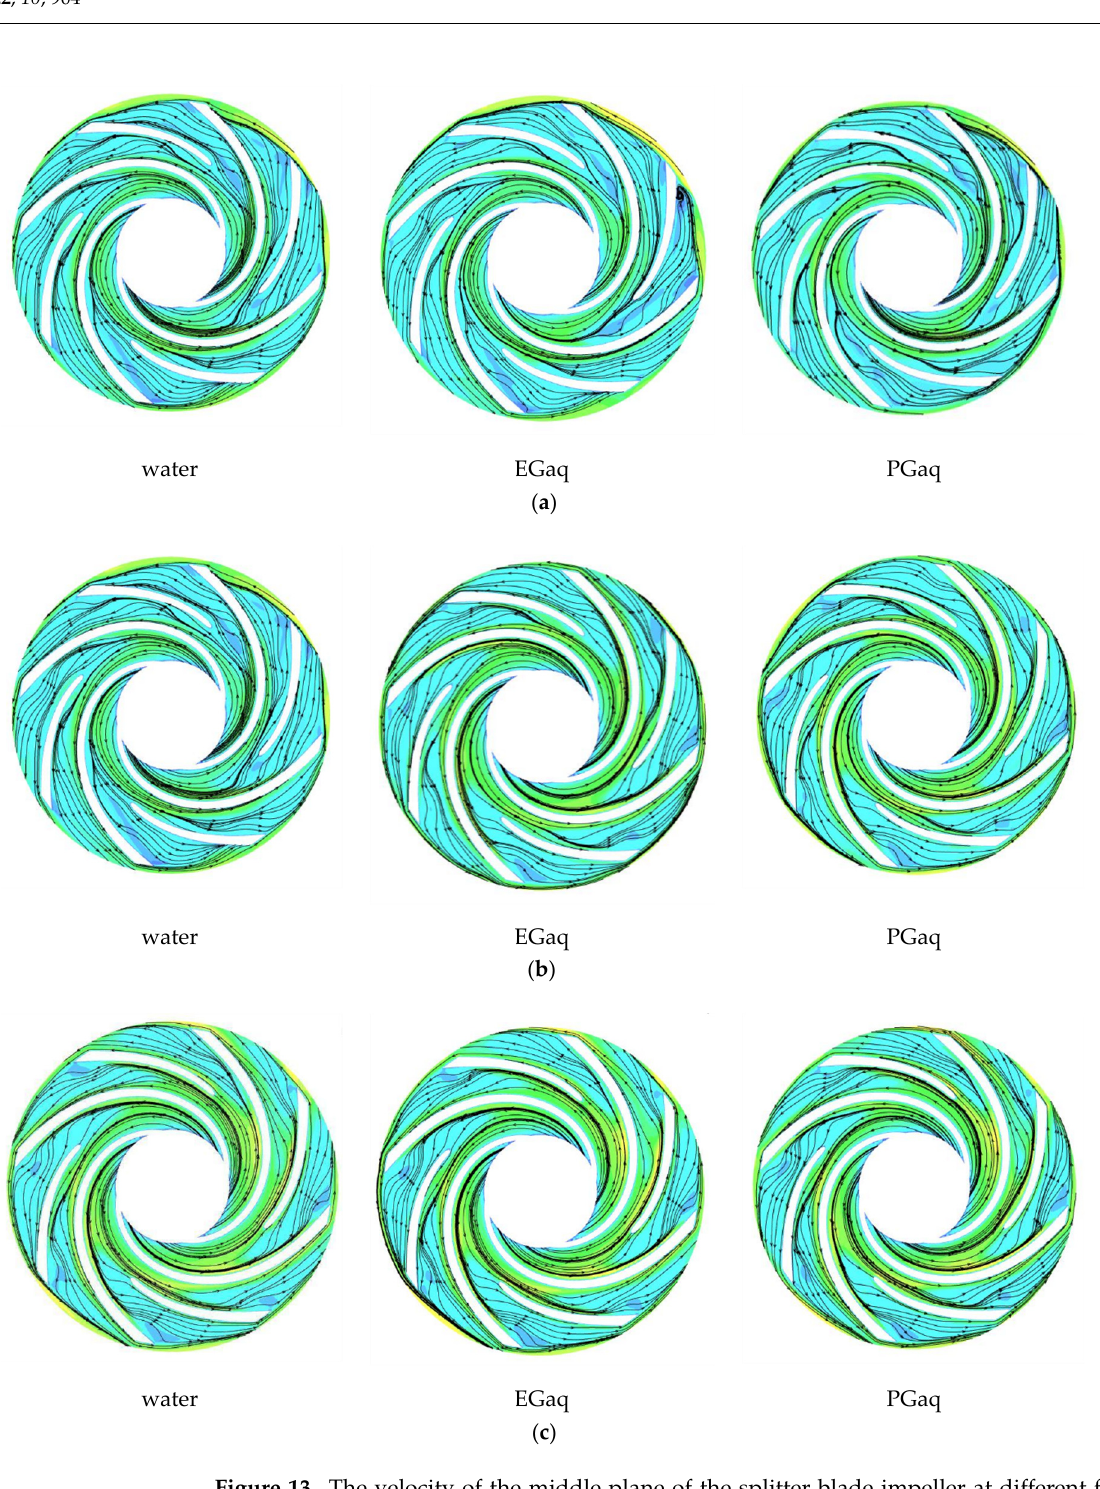
Figure 12. The velocity of the middle plane of the cylindrical blade impeller at different flow rates.